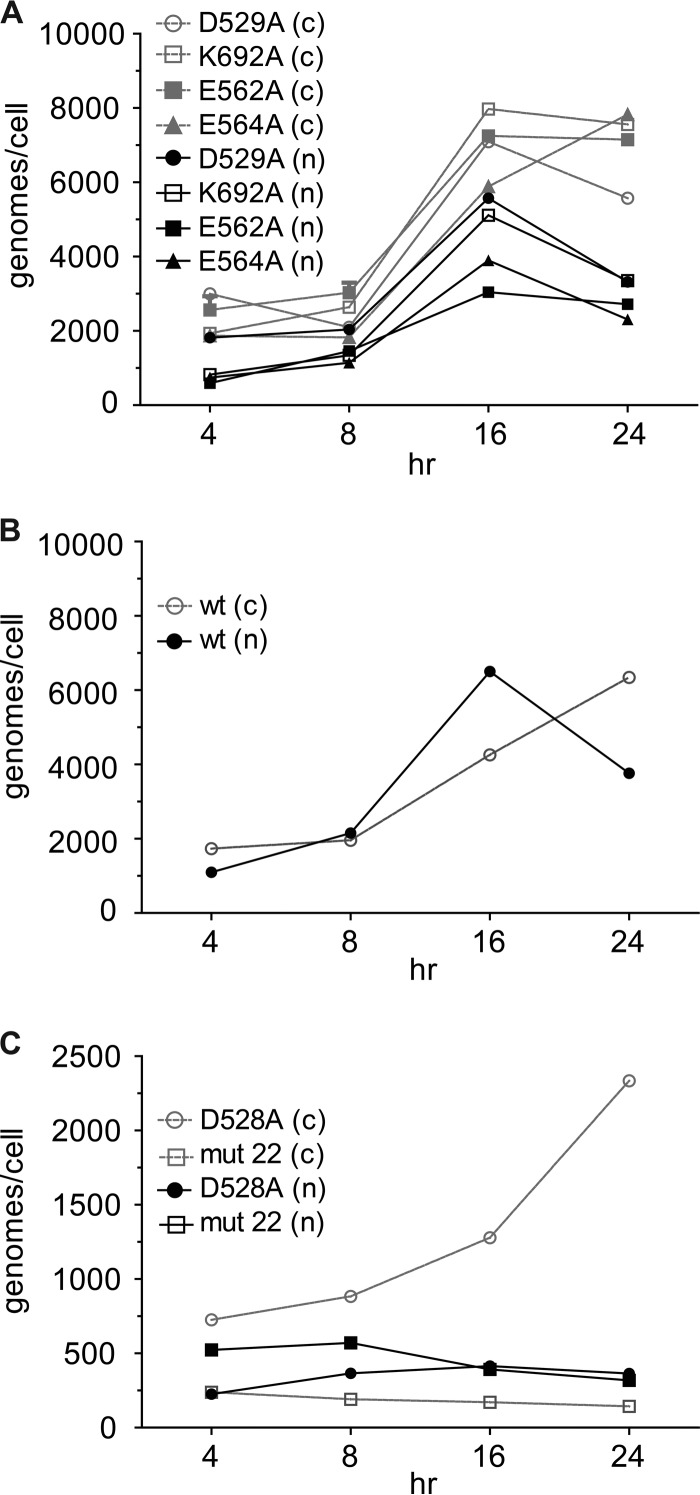
Distribution of virus between the nucleus (n) and cytoplasm (c). Mutant viruses that showed little or no defect for cell entry distributed themselves between the nucleus and cytoplasm approximately the same as the wt virus (compare panels A and B) as a function of time. In contrast, the D528A mutant showed a much higher level of retention of virus in the cytoplasm over time, while mut22 showed a much higher relative level of accumulation of virus in the nucleus than the wt (compare panels B and C). Data for each time point are the means of results from three separate experiments; error bars were omitted for clarity.